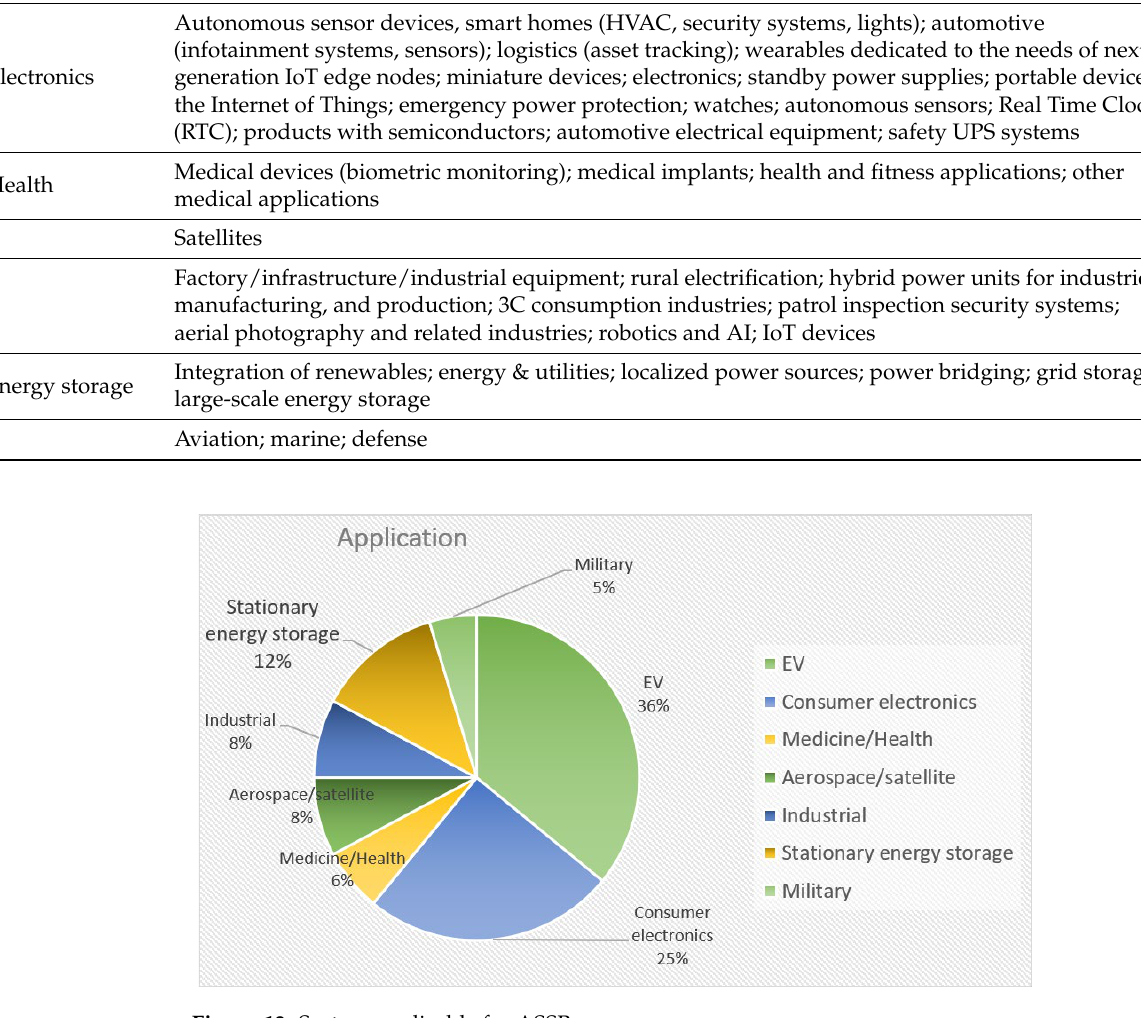
Figure 13. Sectors applicable for ASSB use.